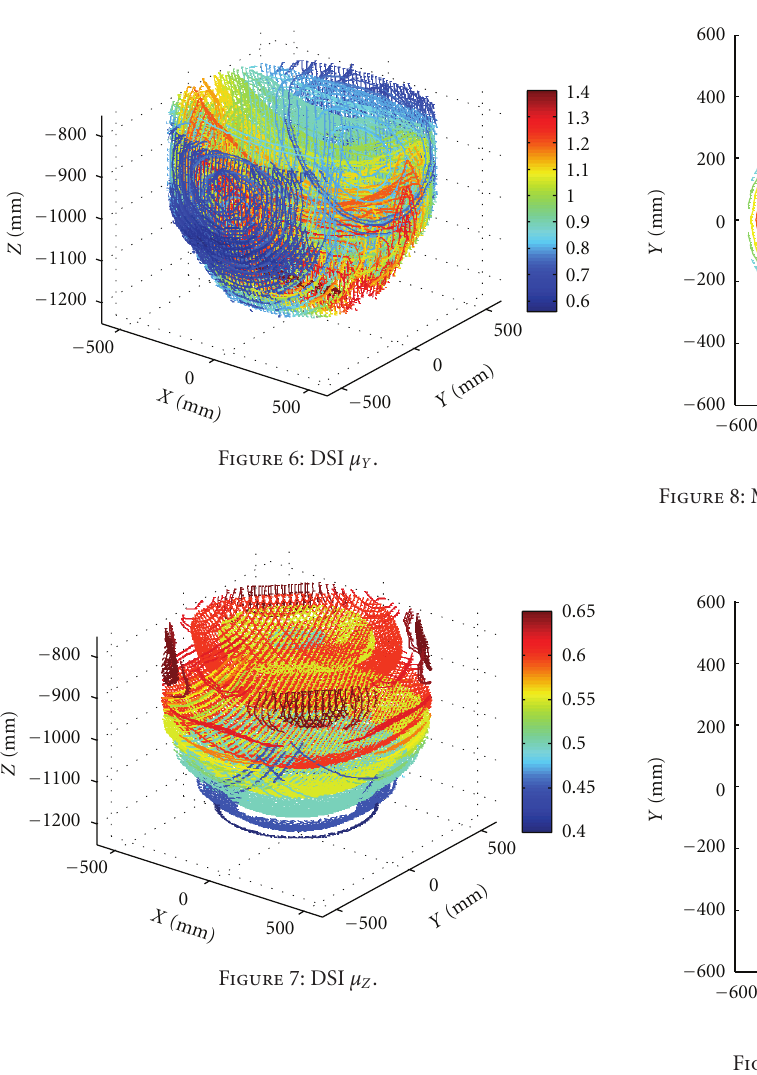
Figure 9: DSI μ X in the XY plane ( Z = −